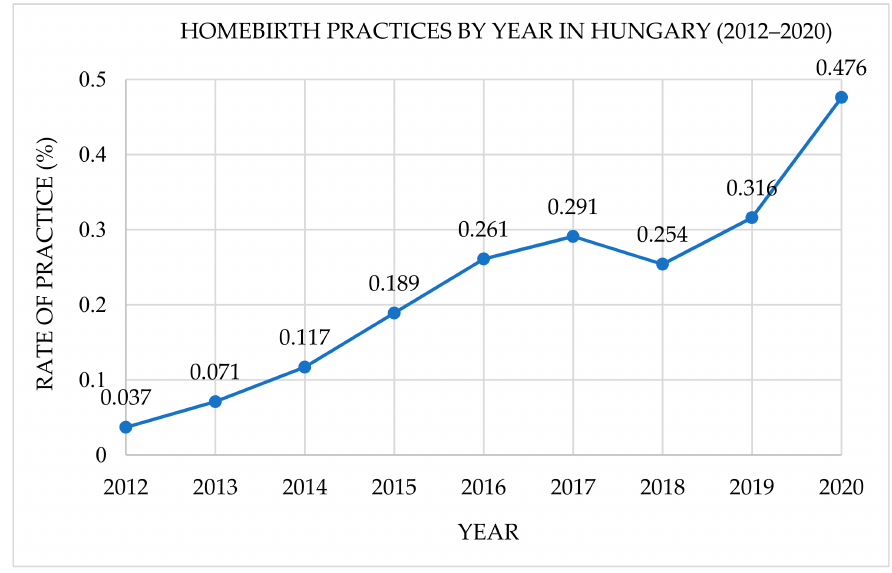
Figure 1. Trends of homebirth practices by year in Hungary